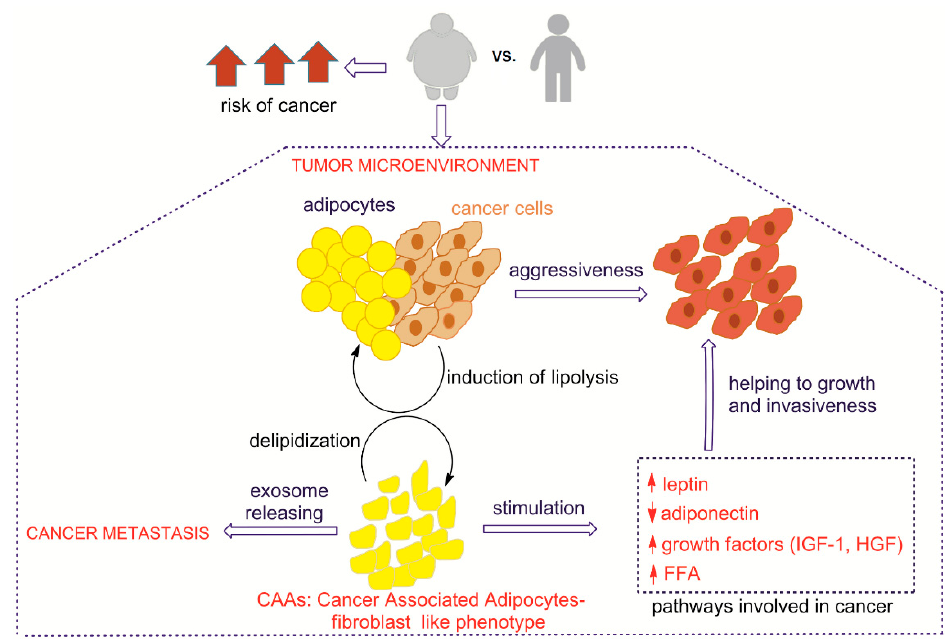
Figure 5. Relevant metabolic connections between adipose and cancer tissues; the arrow ↑ means increase, the arrow ↓ means decrease.